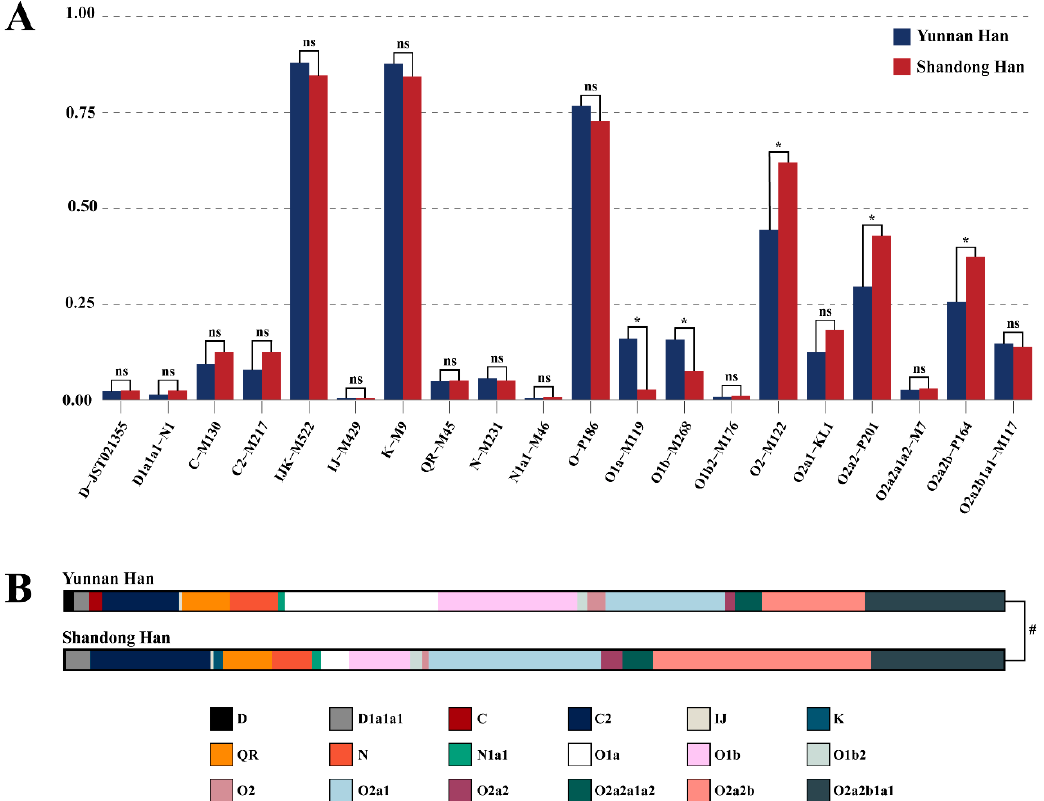
Figure 3. Allelic frequency and haplogroup distribution determined for 24 Y chromosomal single-nucleotide polymorphisms (Y-SNPs) in Yunnan and Shandong Han populations. ( A ) Frequencies for 20 Y-SNP loci with derived allele. Yunnan Han population is represented by blue bars, while Shandong Han population is represented by red bars. “*” and “ns” denote if the allelic frequency comparison is significant or not, respectively. ( B ) Distribution of Y chromosome haplogroups. Different haplogroups are presented with different colors. The upper bar is the haplogroup distribution of Yunnan Han, and the lower one is that of Shandong Han. “#” denotes a significant difference in haplogroup distribution.